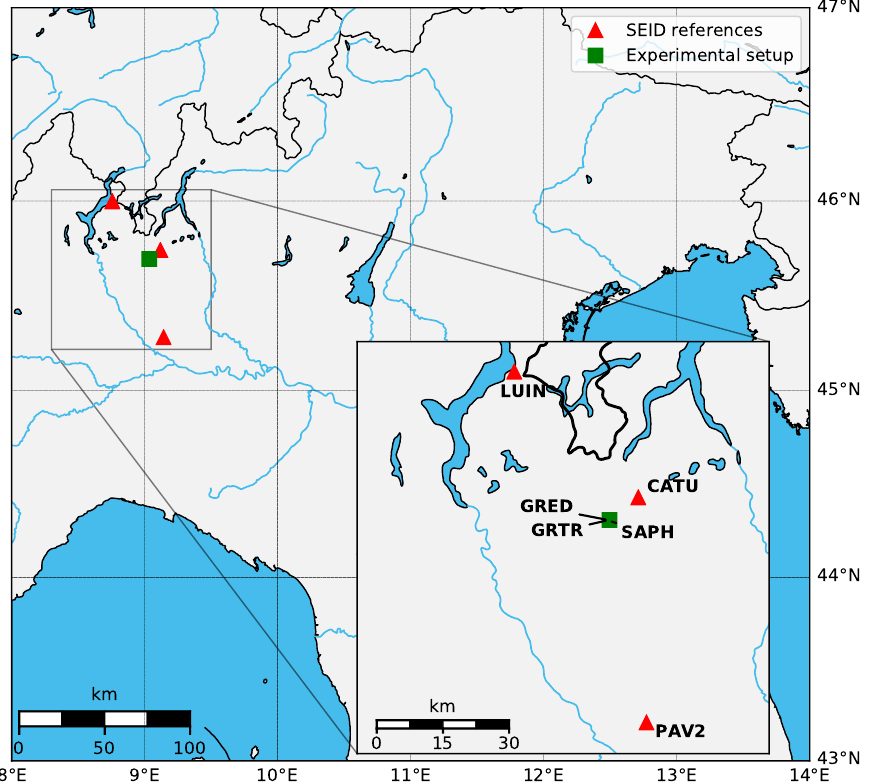
Figure 8. Positions of the Italy-experiment SEID reference stations constellation (red triangles) and experimental setup (green square). The sites GRTR, GRED, and SAPH use the same Trimble Zephyr 2 antenna (TRM55971.00). GRTR is the dual-frequency receiver reference (Trimble BD930 receiver), GRED the cost-efficient single-frequency device (u-blox), and SAPH a low-cost experimental dual-frequency